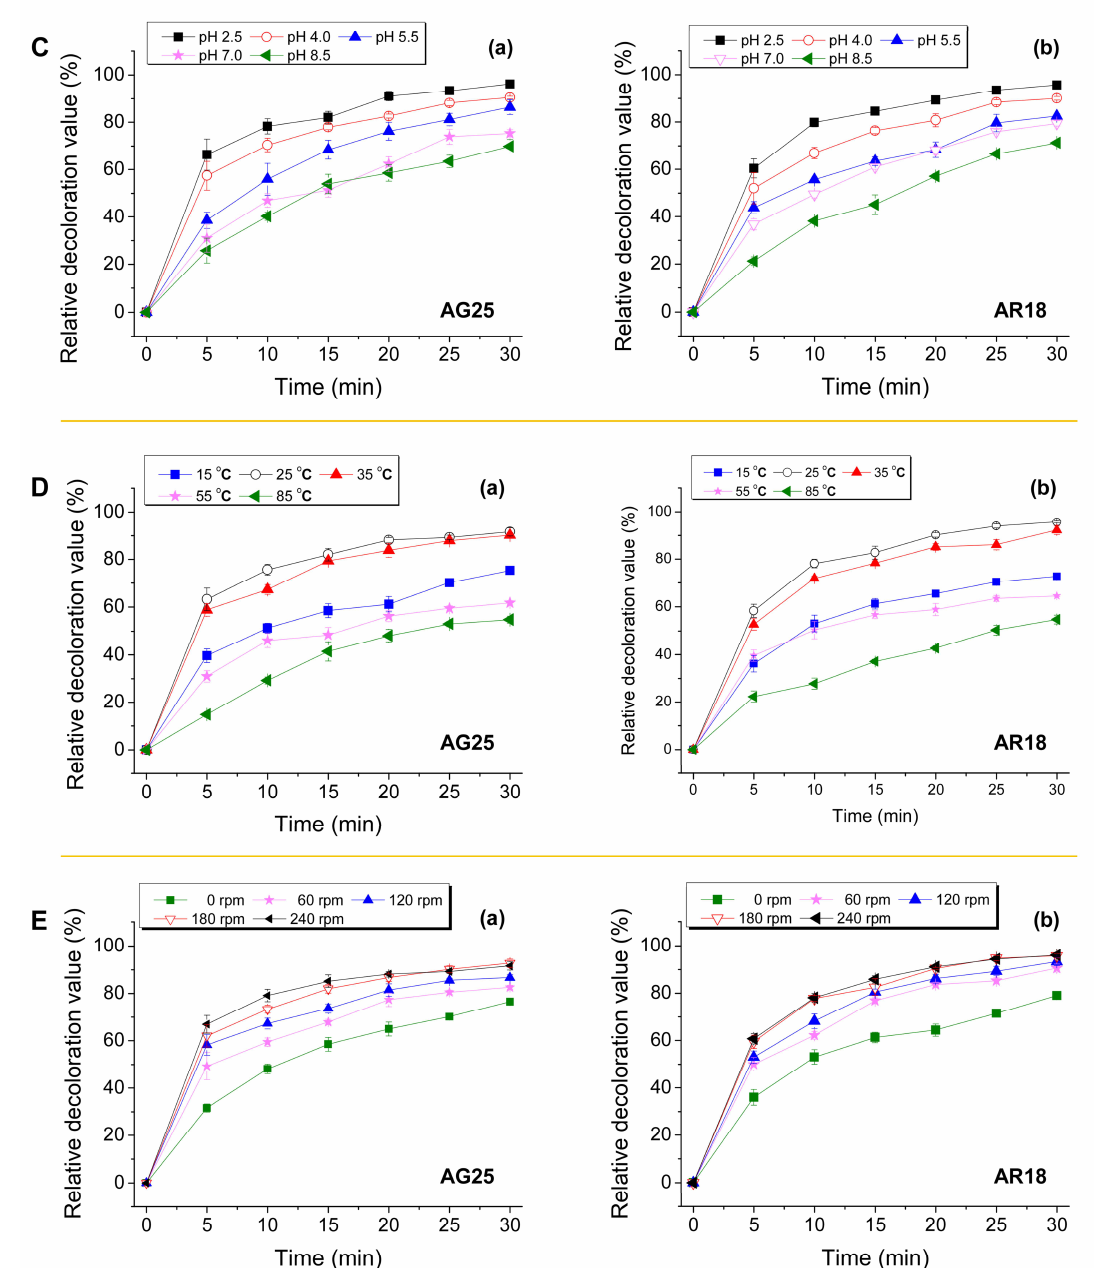
Figure 5. Effect of reaction time ( A ), bacCTS-MB1 loading ( B ), pH value ( C ), temperature ( D ) and shaking speed ( E ) on AG25 and AR18 decolorization by the IBCC-B1s. Each reaction included 2 g (unless otherwise specified) of the bacCTS-MB1s (wet weight) and a final concentration of 1 g L − 1 of the dye